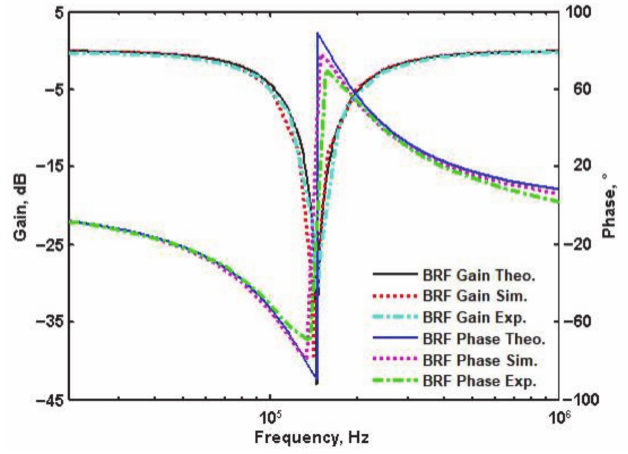
Figure 8. Comparison of BRF experimental response, simulated response, and theoretical response in Part I.